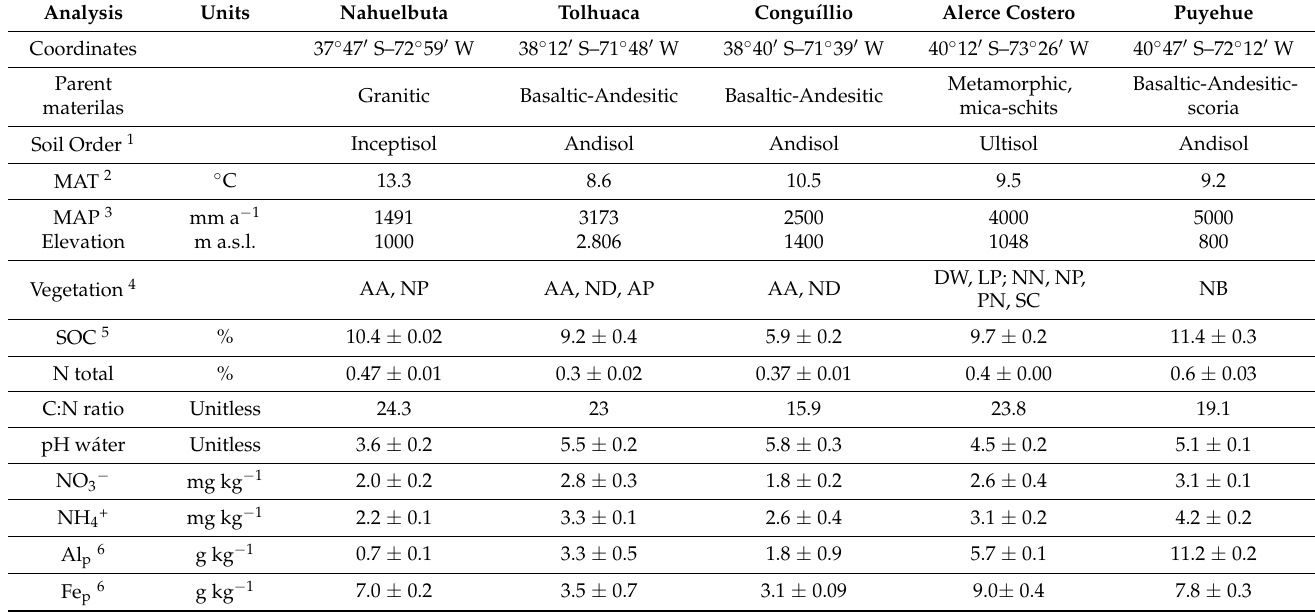
Table 1. Study sites and soil